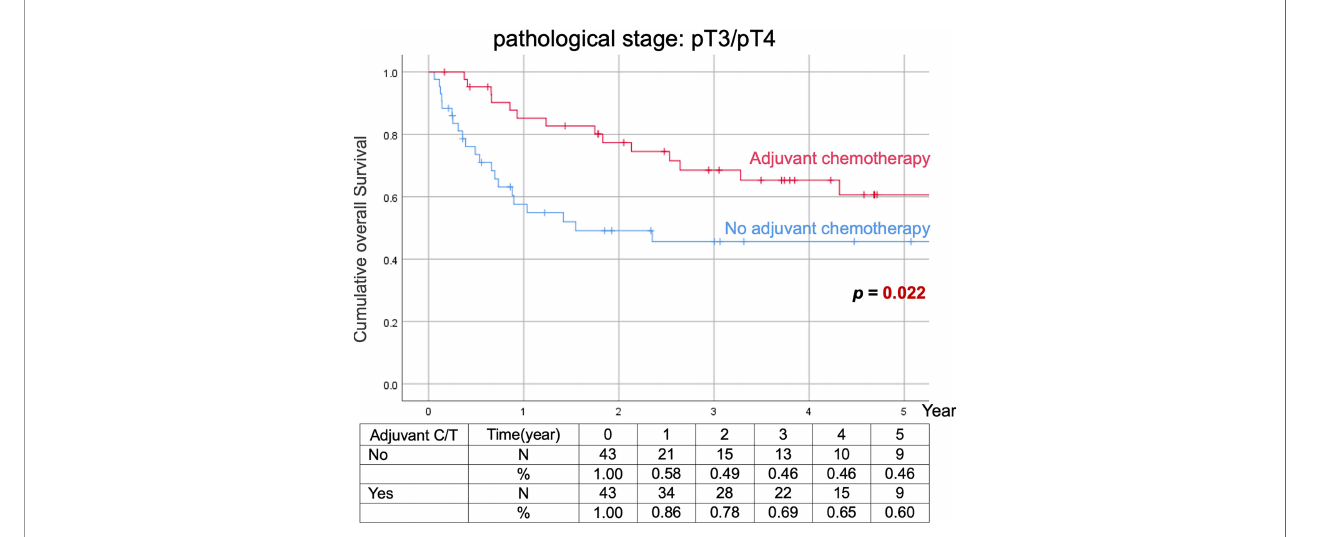
FIGURE 2 | Kaplan – Meier analyses of overall survival in patients with advanced vUTUC with or without adjuvant